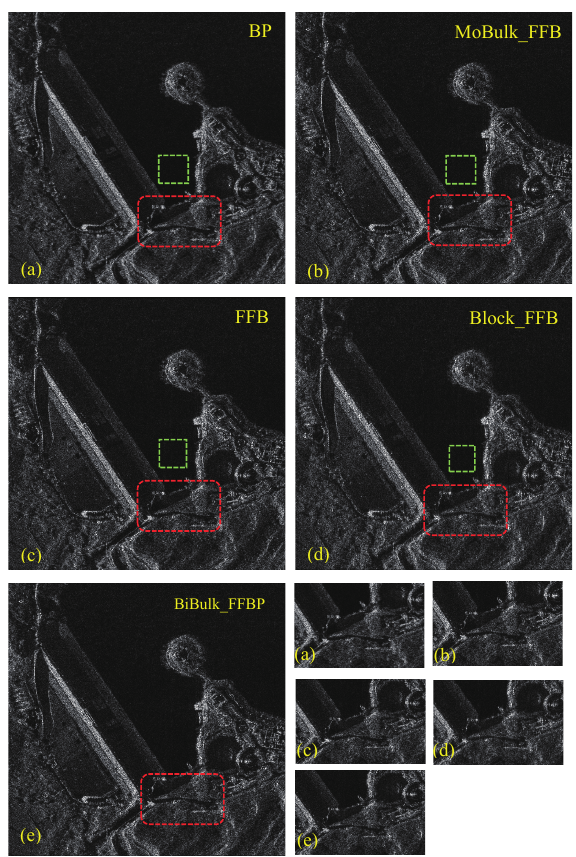
Figure 11. Focusing results of the synthesized distributed scene. Processing result with ( a ) BP, ( b ) MoBulk_FFBP, ( c ) FFBP, ( d ) Block_FFBP and ( e ) BiBulk_FFBP for azimuth-invariant bistatic